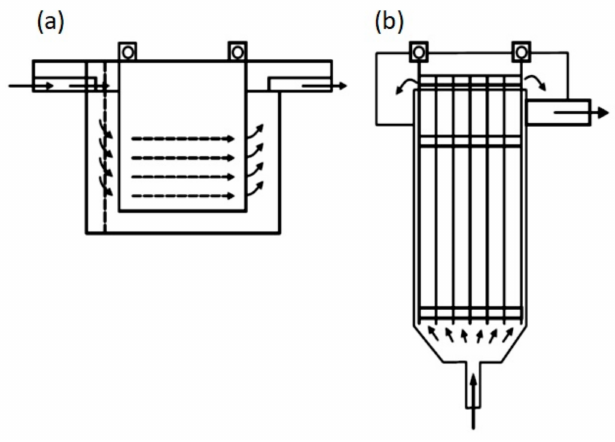
Figure 6. Types of reactors: ( a ) Horizontal flow; ( b ) Vertical flow